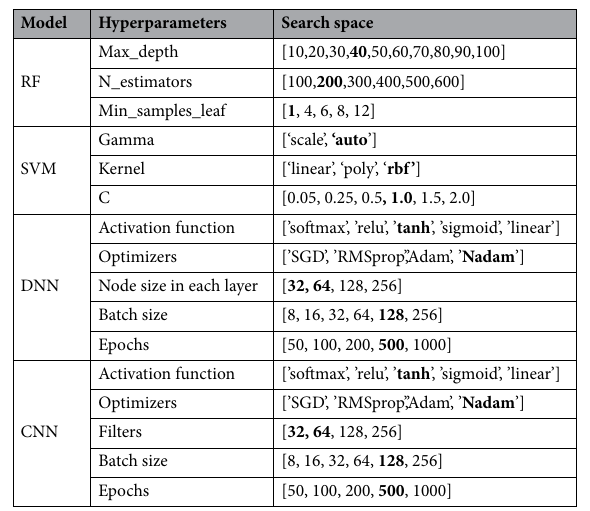
Table 2. Parameter search space for optimizing RF, SVM, DNN and CNN models. The optimal parameter values are in